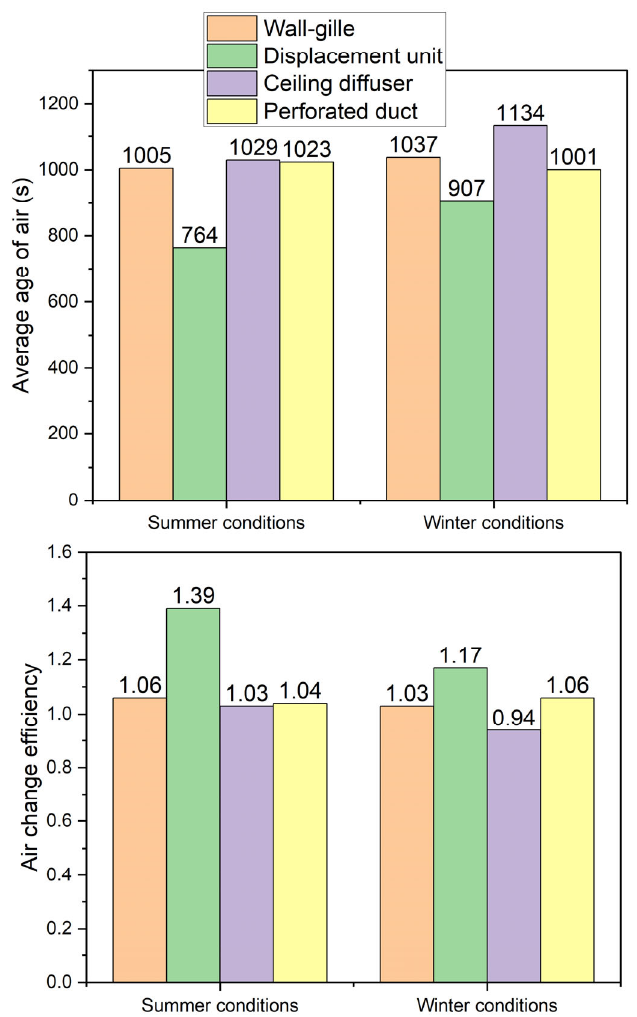
Figure 8. Average age of air in the occupied zone and air change efficiency of four air distribution methods.